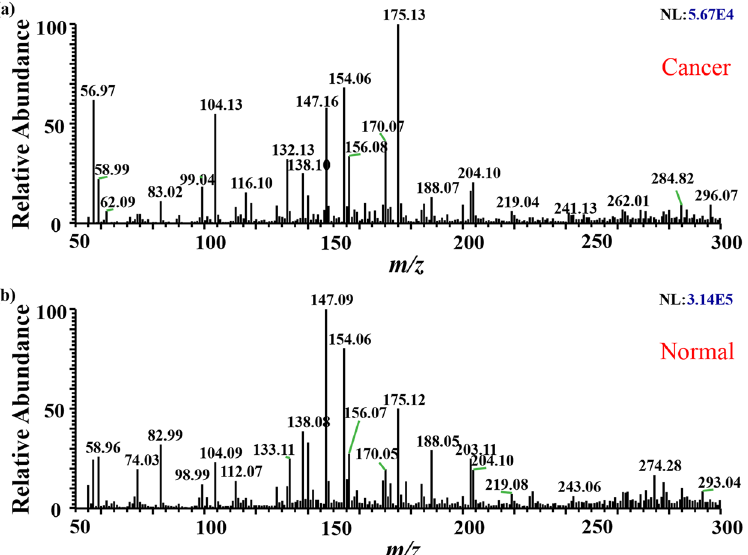
Figure 1. Spectra obtained from human oesophageal cancer tissues and adjacent normal tissue. ( a ) Cancerous tissue in positive ion mode with main peaks at m/z 56.97, m/z 104.13, m/z 116.10, m/z 132.13, m/z 147.16, m/z 154.06, m/z 156.08, and m/z 175.13. ( b ) Normal tissue in positive ion mode with main peaks at m/z 58.96, m/z 74.03, m/z 82.99, m/z 133.11, m/z 138.03, m/z 147.09, m/z 154.06, m/z 175.12 and m/z 188.05.